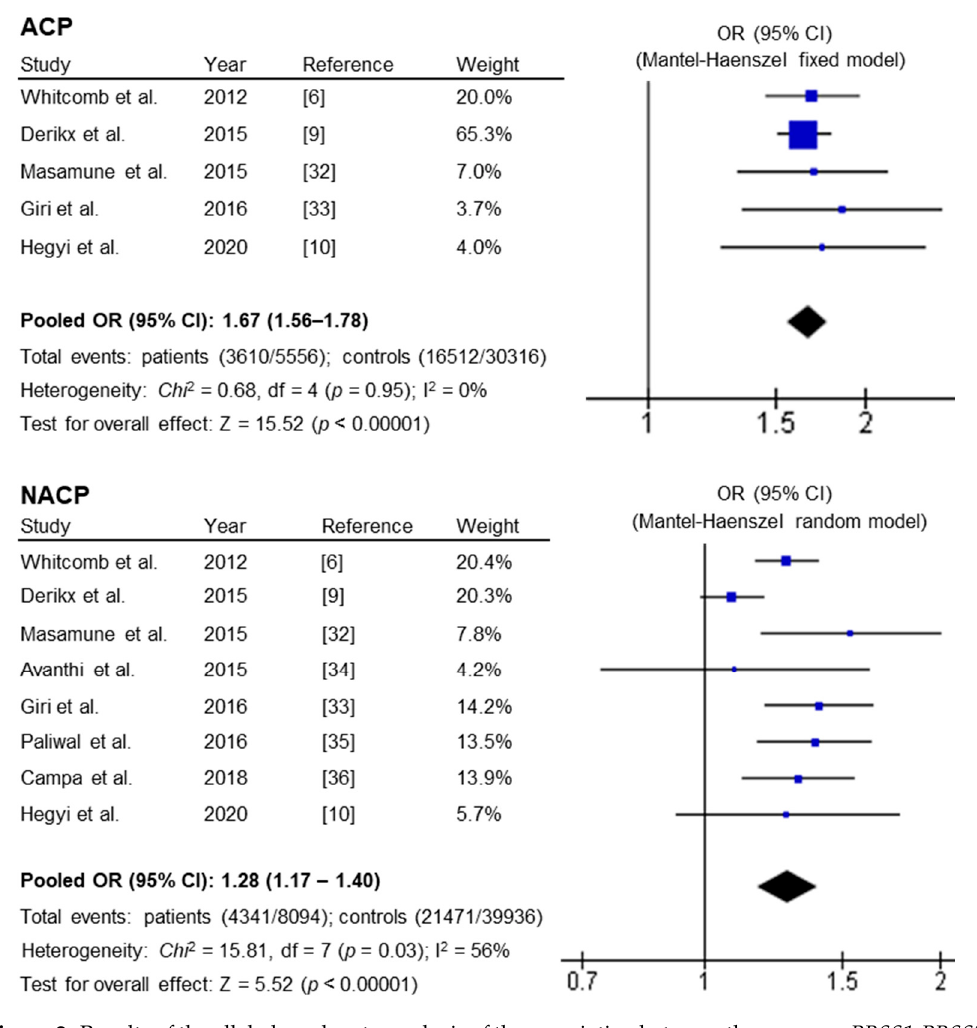
Figure 2. Results of the allele-based meta-analysis of the association between the common PRSS1-PRSS2 haplotype and ACP or NACP, and the corresponding forest plots. Total events in patients and controls: number of risk alleles / number of total alleles. See Table 1 for the risk allele distribution data, OR (95% CI) and p values in the context of each individual study. Abbreviations: ACP, alcoholic chronic pancreatitis; CI, confidence interval; NACP, non-alcoholic chronic pancreatitis; OR, odds ratio.